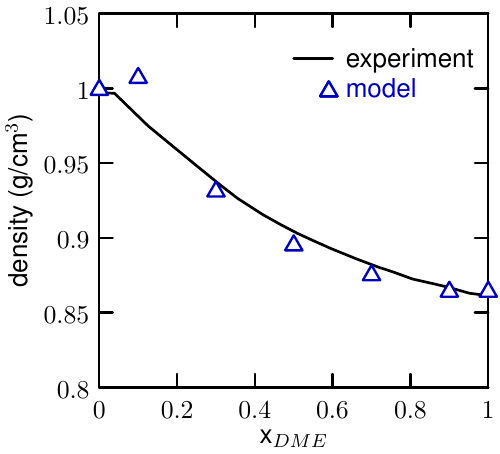
Figure 2. Density of The water/DME